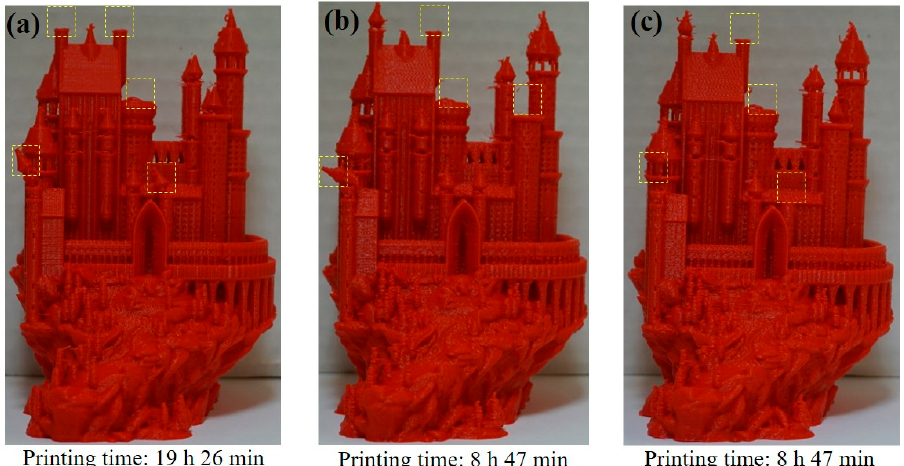
Figure 8. Prints of Medieval Castle using: ( a ) local controller (Marlin); ( b ) cloud-based controller in South Carolina; and ( c ) cloud-based controller in Australia. The portions of the prints highlighted in dashed rectangles failed (broke off) during printing due to their very delicate support